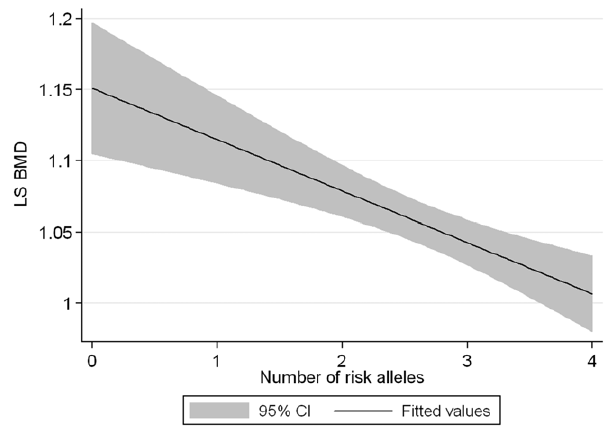
Table S2 Genetic association between MAP3K14 SNPs and BMD v . (DOC)